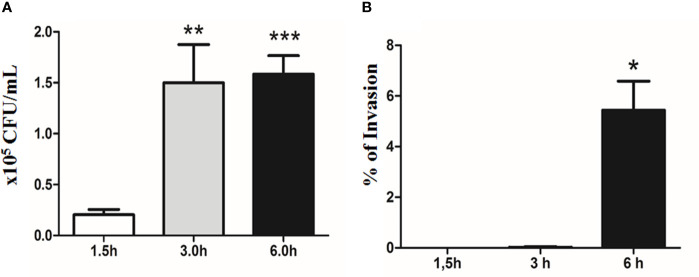
Quantitative bacterial adherence and invasion indexes of E. albertii 1551-2 in differentiated Caco-2 cells at 1.5, 3, and 6 h. (A)
E. albertii 1551-2 can associate with Caco-2 cells efficiently within 3 h after infection. The number of associated bacteria did not change between 3 and 6 h, suggesting that, at 3 h, bacteria have occupied most of the host sites available in vitro under this condition. **p < 0.01 and ***p < 0.001. (B) No intracellular bacteria were recovered after 1.5 h of infection. A low number of bacteria was detected at 3 h (0.2% of invasion). *p < 0.05. The results at 3 and 6 h were compared with those obtained in 1.5 h.